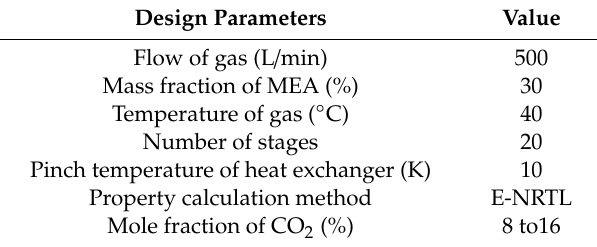
Table 4. Information of the equilibrium model.